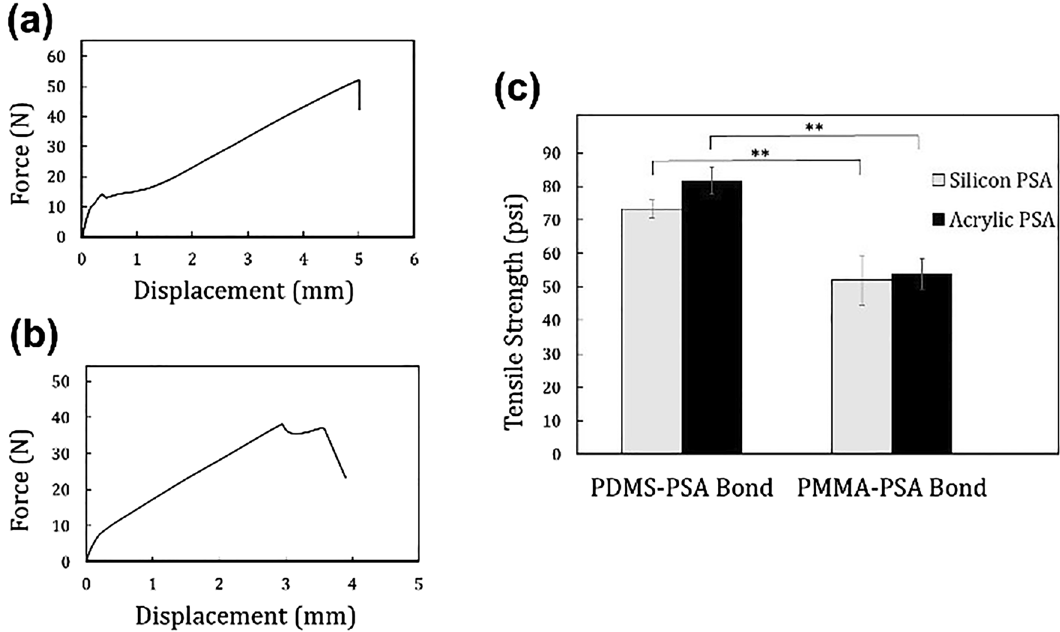
Figure 4. Tensile strength test of the PDMS–PSA–PMMA bond measured at a displacement rate of 3 mm min −1 . The load–displacement curve of ( a ) PMMA–PSA and ( b ) PDMS–PSA bonds in which the